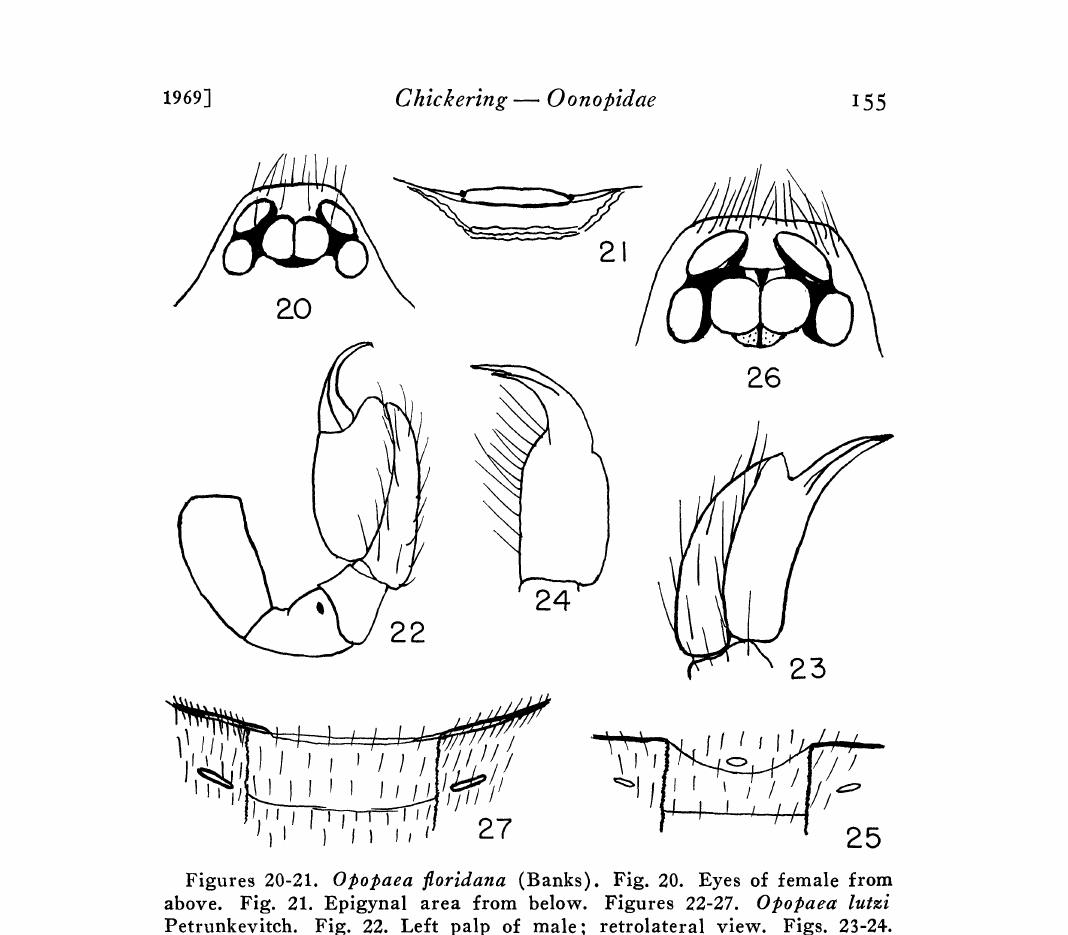
Fig. 25. Genital area of male from below. Fig. 26. Eyes of female from above. Fig. 27. Epigynal area of female from